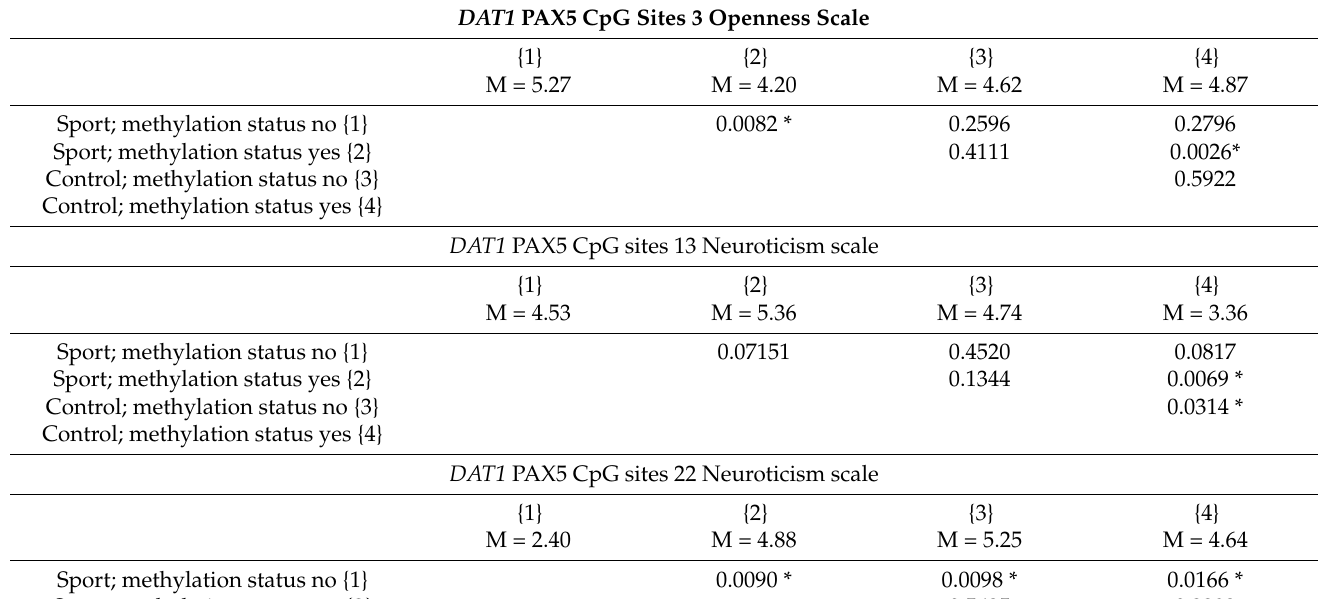
Table 4. Post hoc analysis of interactions between sports subjects/control and DAT1 PAX5 CpG sites 3, 13, 22, 33 and NEO FFI